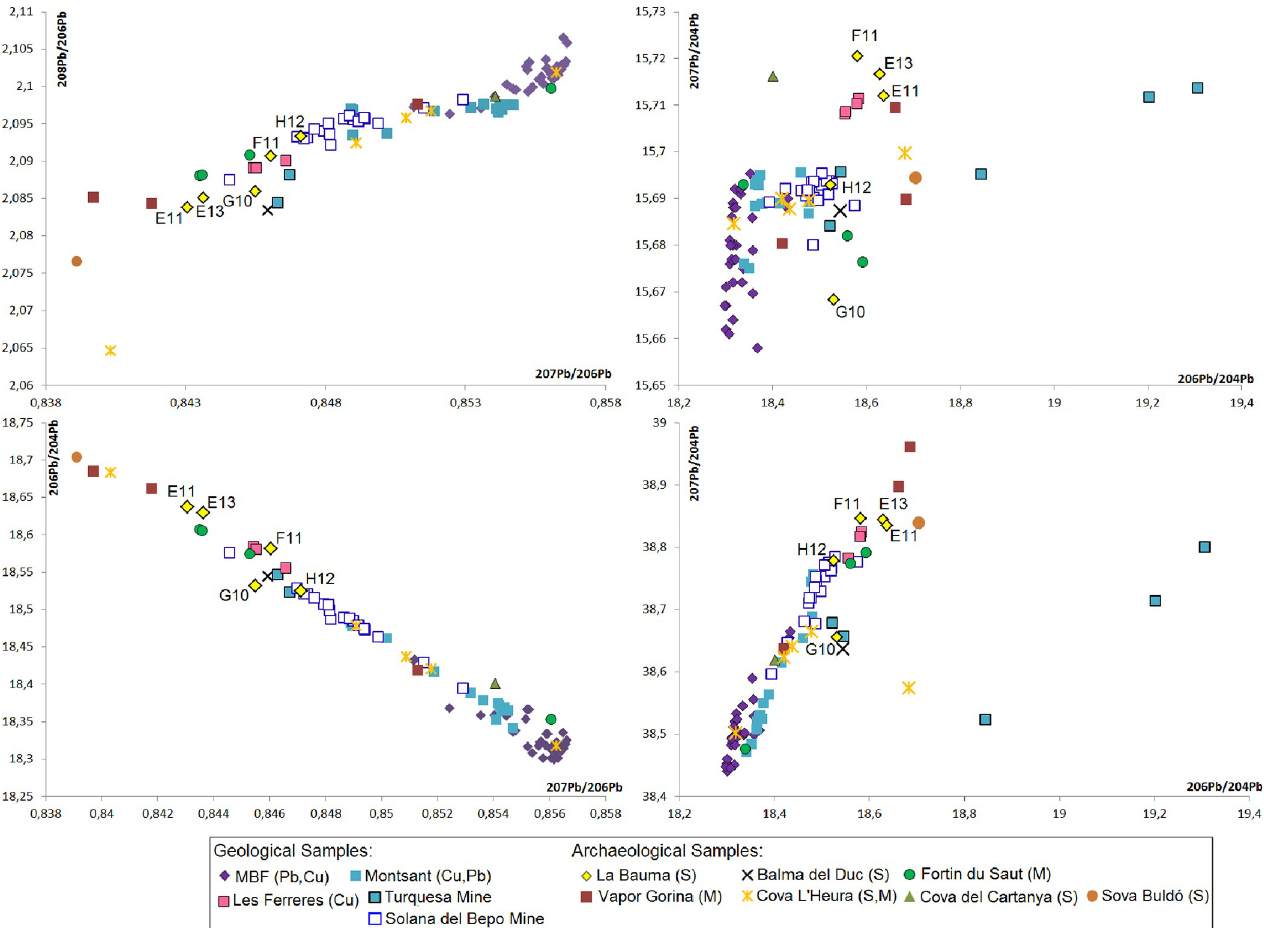
Fig 19. LIA results for samples from La Bauma, other sites located in the Northeast and geological samples of the region. These include Les Ferreres mine (this paper) and the MBF [77] and Montsant mining districts [54, 58, 78]. Solana del Bepo and Turquesa mines are part of the latter. Not all samples from Turquesa mine (n. 12) are represented in the graphs, as samples from this source have a radiogenic trend that reaches values of 21.750 206 Pb/ 204 Pb; 15.857 207 Pb/ 204 Pb; 38.898 208 Pb/ 204 Pb; 0.7291 207 Pb/ 206 Pb and 1.788 208 Pb/ 206 Pb. In archaeological samples, S = Slag; M = Metals. Data for archaeological samples was taken from Montero Ruiz [58] and Laubane